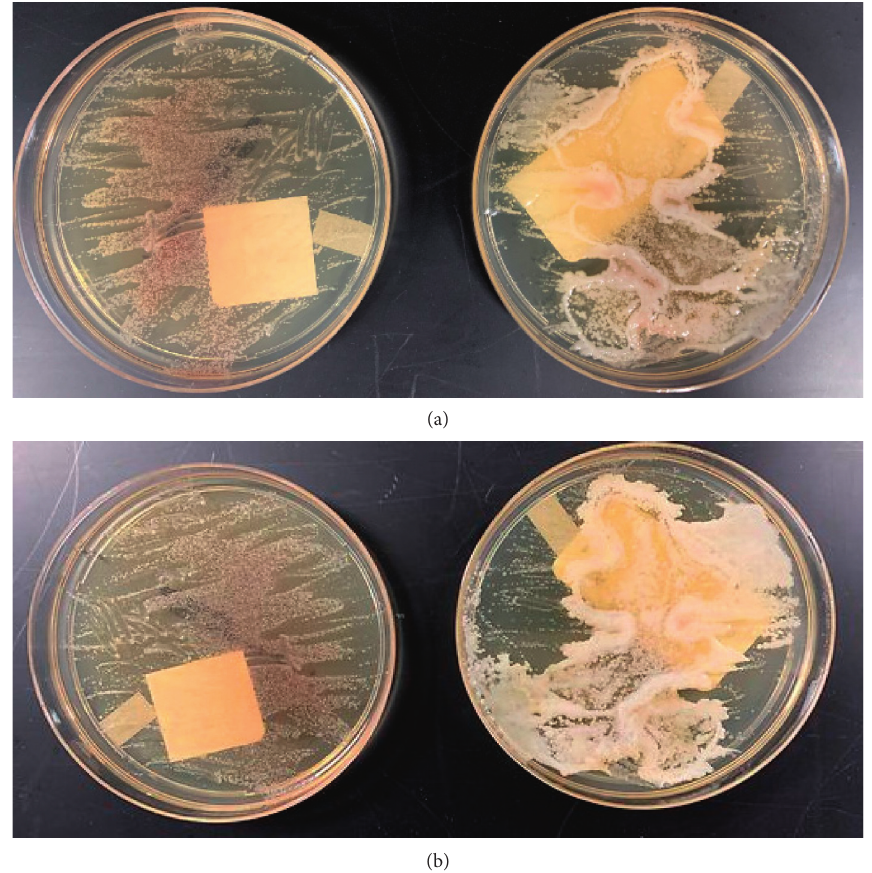
Figure 2: Growth on SDA vs. SDA with long-chain fatty acid supplementation, 30 ° C. Day 5 (a) vs. day 10